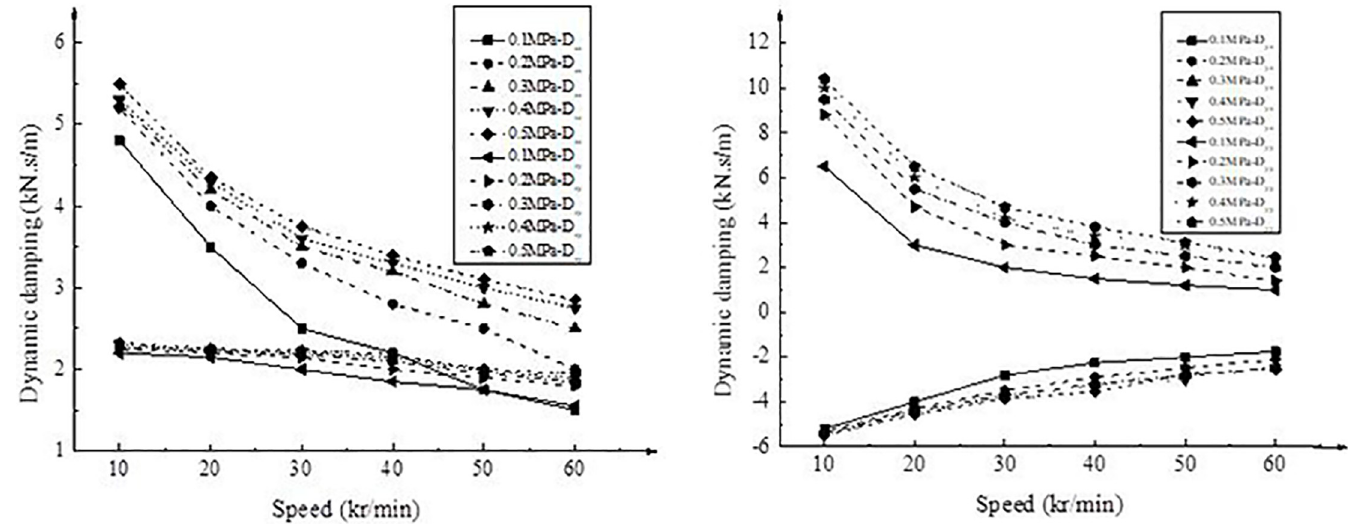
Fig 7. Distribution and changes of dynamic damping for gas bearing-rotor system: (a) D xx and D xy ; (b) D yx and D yy .